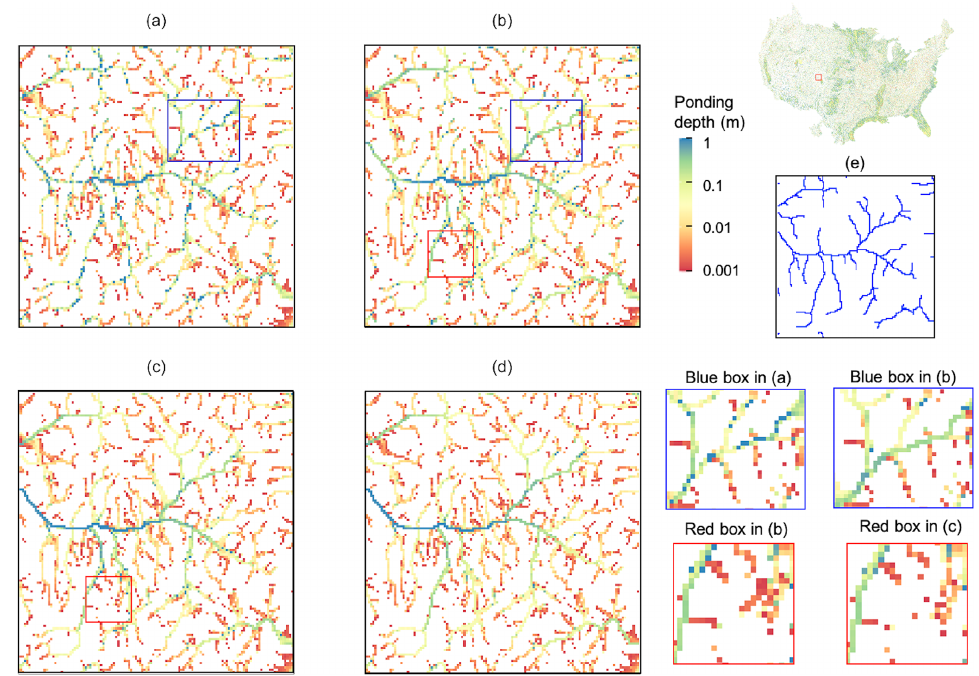
Figure 8. The ponding depth from runoff tests from four slope cases. (a) No smooth. (b) Add stream smooth. (c) Add flat fix. (d) Remove secondary. Panel (e) is the stream network from the Priority Flood approach with drainage area over 100km 2 . The blue and red boxes are examples to be explained in detail in the